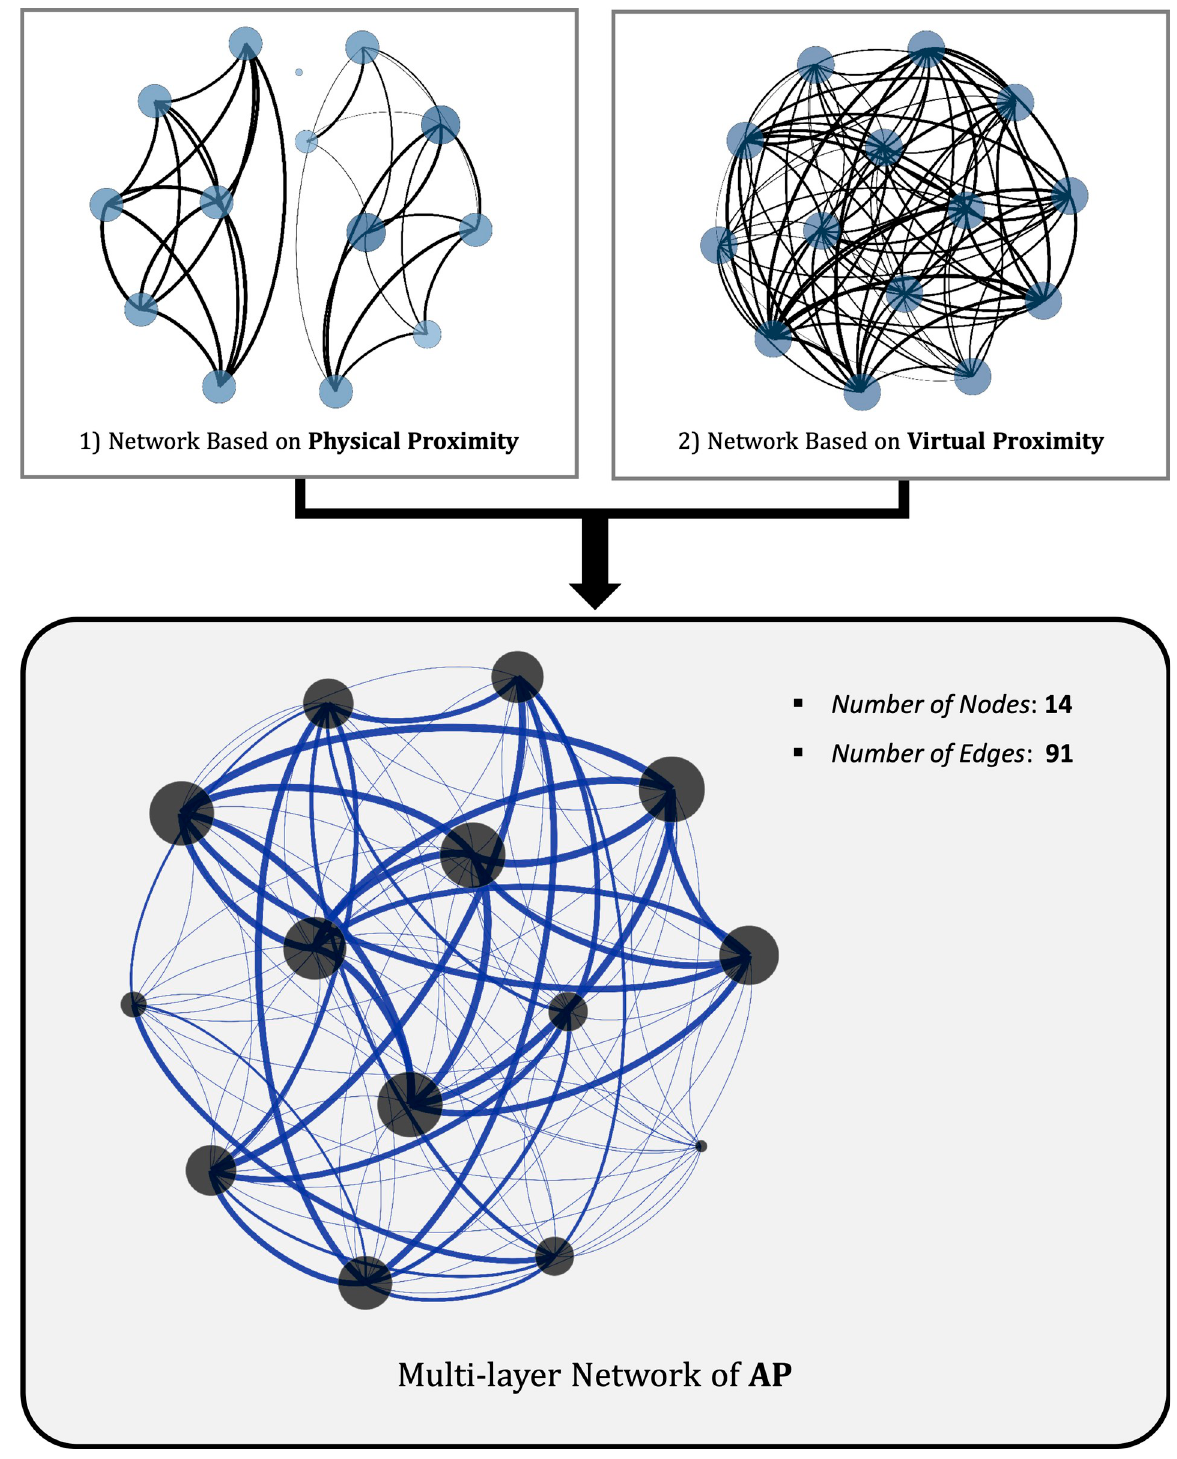
Fig 6. Visual representation of augmented-proximity (AP)-based multi-layer network through convergence of physical- and virtual- proximity networks based on service 1.